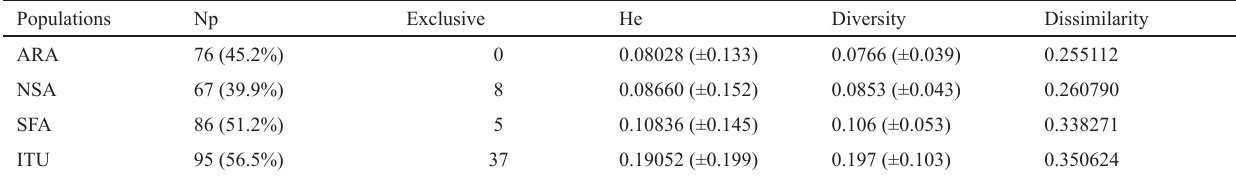
Table 1. Comparison of key parameter indicators genetic diversity within each population Arapaima gigas . (Np) Number of polymorphic loci; Number of exclusive loci, (He) expected heterozygosity; average gene diversity of all haplotypic loci and intra-population genetic dissimilarity, using the Jaccard coefficient. (ARA) Araguaiana-MT, (NSA) Novo Santo Antônio- MT, (SFA) São Félix do Araguaia-MT and (ITU) Itupiranga-PA.